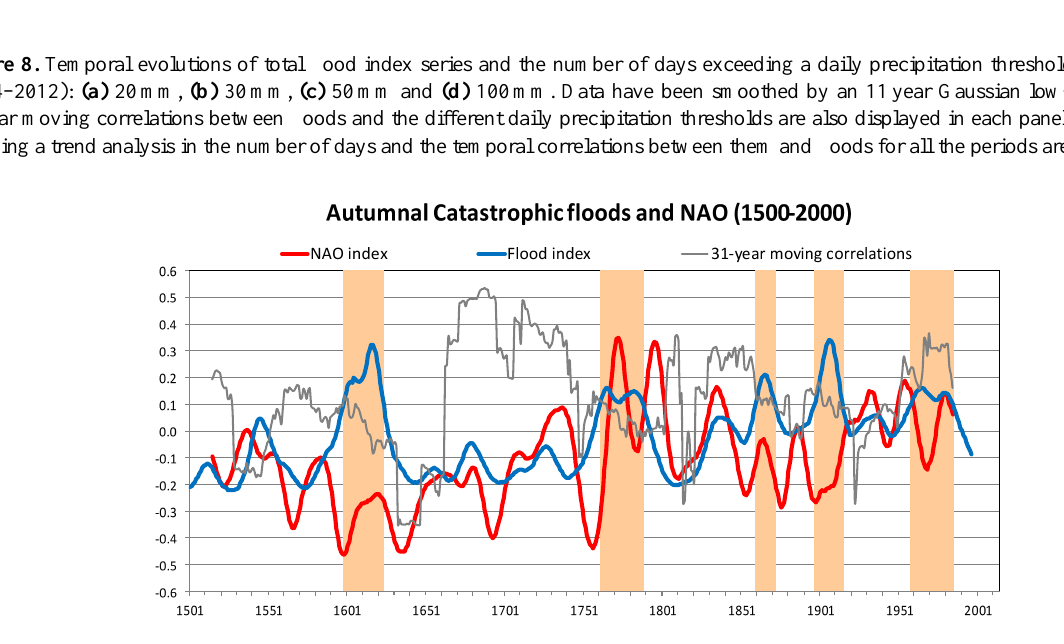
Figure 9. Temporal evolution (1500–2000) of autumnal NAO (Luterbacher et al., 2002; red line), autumnal catastrophic flood index series for Catalonia (blue line) and 31 year moving correlations between both variables (grey line). Data are smoothed by a 31 year low-pass Gaussian filter. The anomalous periods of high flood frequency are